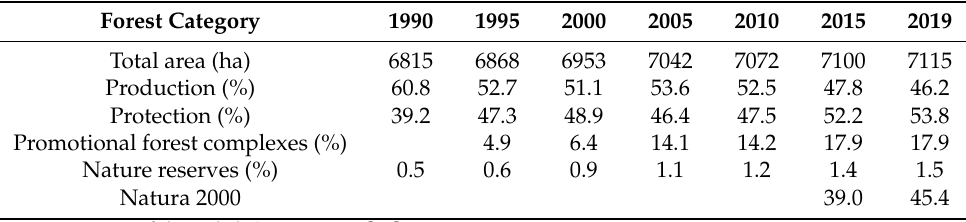
Table 1. Total area and the shares of production and protection forests managed by Polish State Forests in